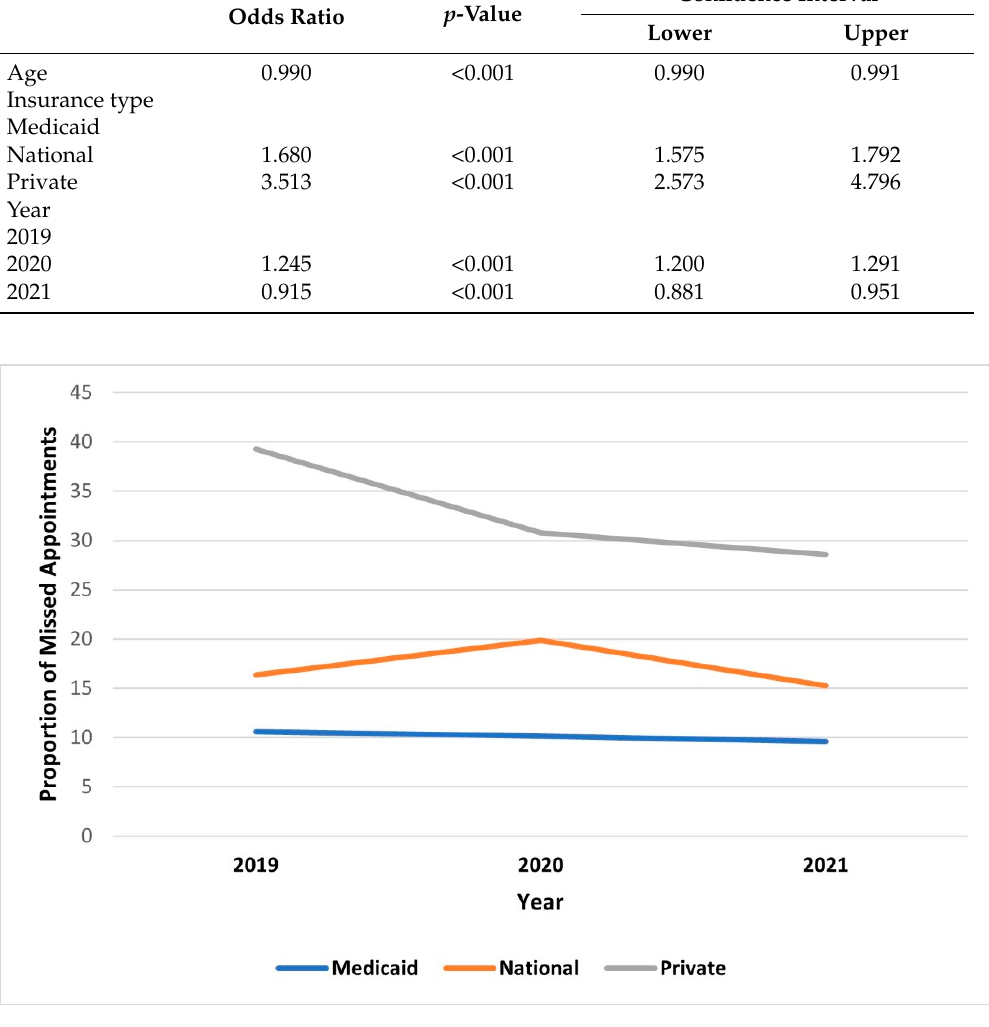
Figure 3. Cancellation rates among different insurance types.